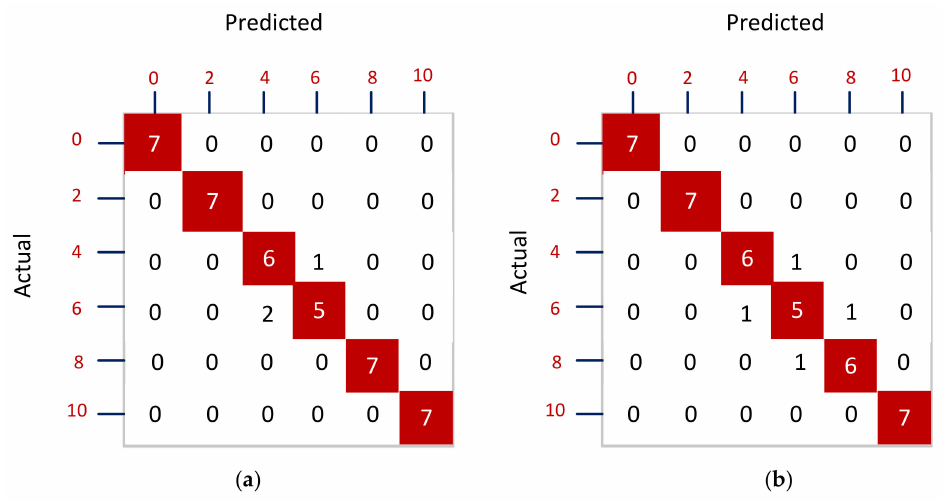
Figure 7. Confusion matrix for detection of food contamination detection (different columns represent the predicted samples while the rows represent the actual samples). ( a ) Salt as contaminant; ( b ) sugar as